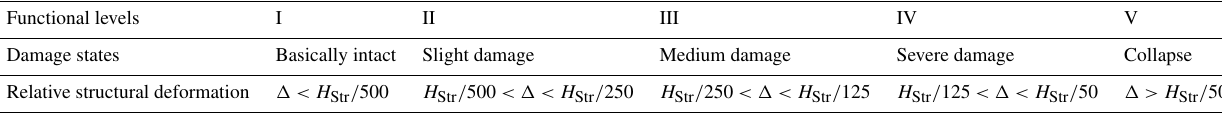
Table 4. Damage to marine structures under extreme ice